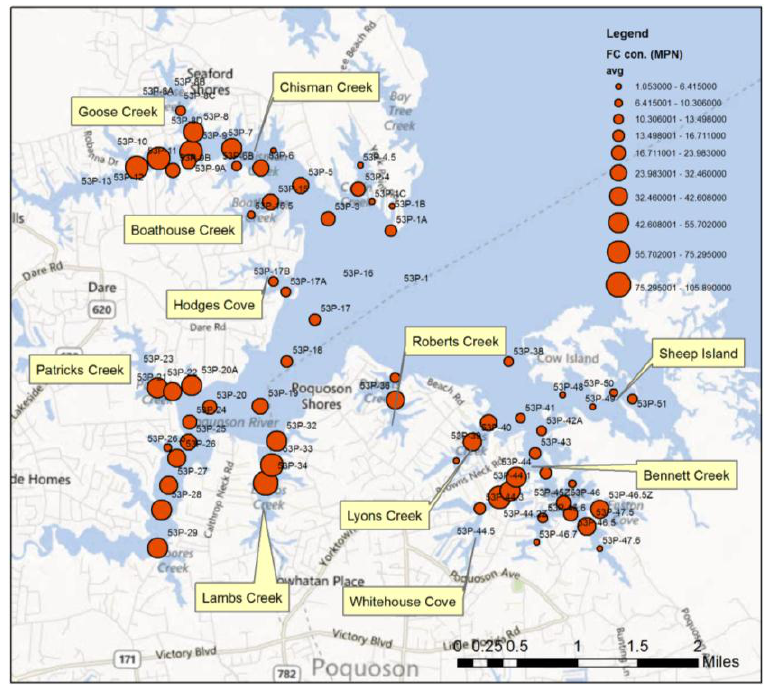
Figure 2. Spatial distribution of mean bacterial concentrations at VDH-DSS stations.